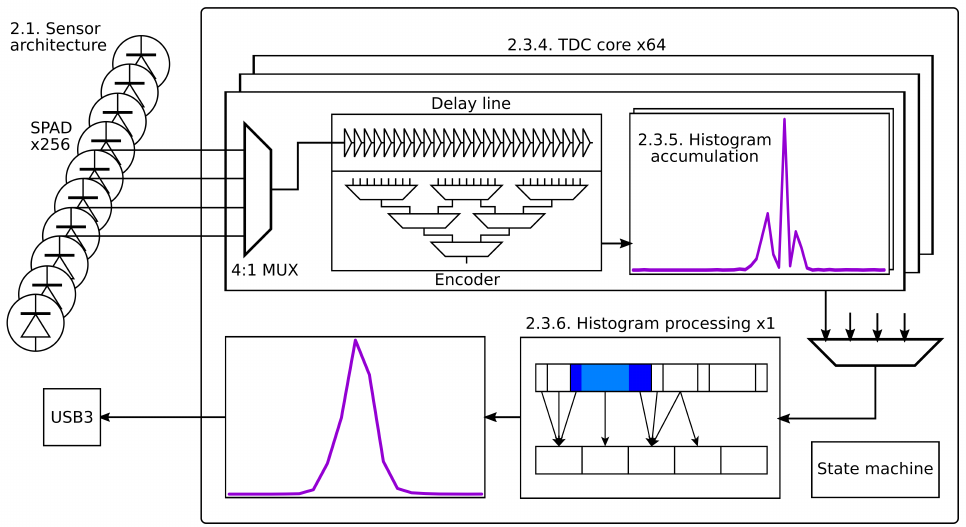
Figure 4. TDC array block detail showing the 64 delay lines with encoders and histogram accumulation engines. A state-machine is used to switch the multiplexer from one pixel to the next and sequence the readout of the accumulated histograms. The histogram engines share the post-processing, which is implemented in the path between the memory and the USB transceiver to process the histograms in real time while they are transferred to the computer. (Labels include section numbers where